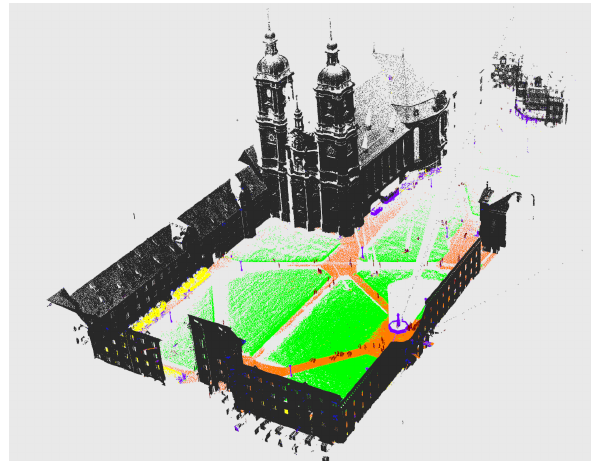
Figure 1. The task: given an unstructured, inhomogeneous point cloud, assign point-wise semantic